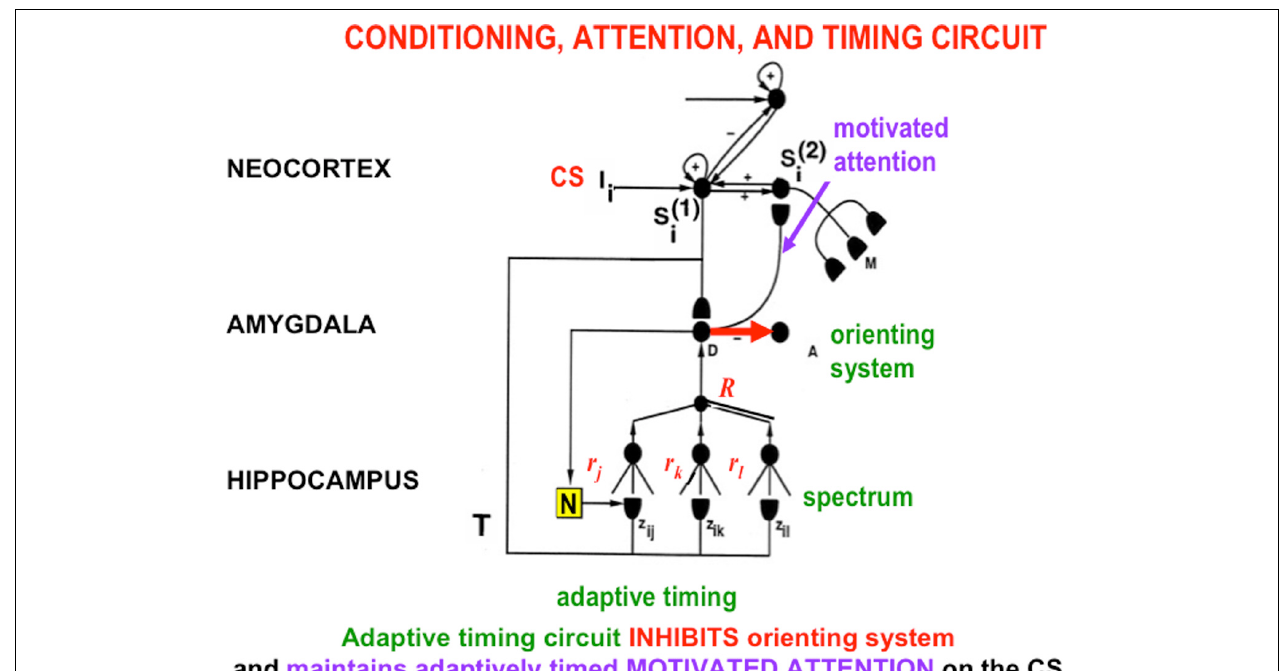
FIGURE 9 | The simplest version of the START (Spectrally Timed Adaptive Resonance Theory) neural model. Adaptively timed learning maintains motivated attention within the temporal-amygdala-orbitofrontal feedback loop ( Figure 8 ) at the same time that it inhibits activation of the orienting system. START hereby combines the reinforcement learning, motivated attention, and action processes of the CogEM model with adaptively timed inhibition of the ART orienting system A ( Figure 7 ). A sensory cortical representation S ( 1 ) i is activated by the CS input I i , and then tries to activate its orbitofrontal cortical projection in S ( 2 ) i . This happens while it also competes with other sensory representations and sends conditioned reinforcer signals to the drive representation, D , which plays the role of the amygdala in the model. Learning from S ( 1 ) i to D is conditioned reinforcer learning, whereas learning from D to S ( 2 ) i is incentive motivational learning. The S ( 1 ) i -to- D -to- S ( 2 ) i -to- S ( 1 ) i feedback loops maintain motivated attention upon motivationally salient objects and events. A parallel branch from the sensory cortex S ( 1 ) i goes to the hippocampus where a spectrum of cells responds at different rates (r j , r k , r l ) to the input signal T (see Figure 10 ). The population response of these cells supports correctly timed learning that can bridge the temporal gaps that occur during trace conditioning and delayed non-match to sample, among other paradigms. When the adaptively timed circuit is active, it maintains motivated attention via the feedback pathway (pathway D → S ( 2 ) i → S ( 1 ) i → D ) for an adaptively timed interval, while it inhibits activation of the orienting system (pathway D → A ) in order to prevent distracting events from interfering with the adaptively timed response that is read out by S ( 2 ) i to acquire a valued goal. [Adapted with permission from Grossberg and Merrill